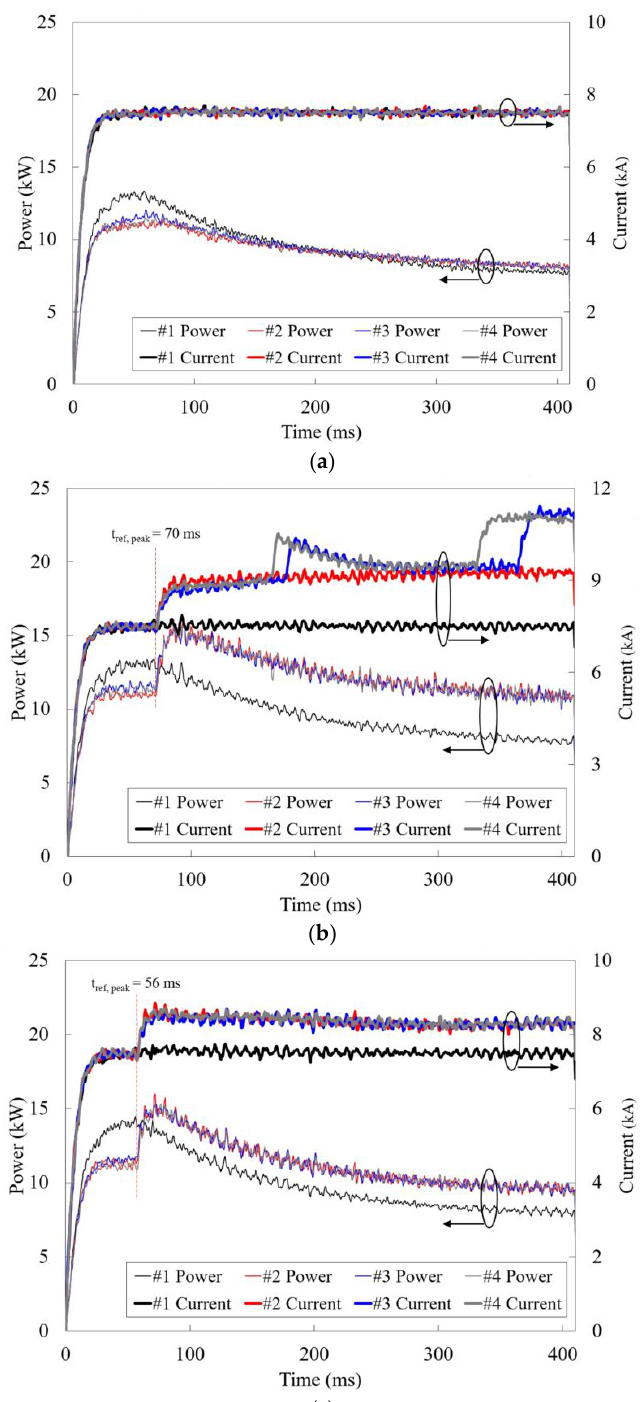
Figure 15. Welding current and power over time and for each of the four welds measured during ( a ) conventional RSW; ( b ) proposed adaptive RSW with C user = 1.0; and ( c ) proposed adaptive RSW with C user = 0.9.